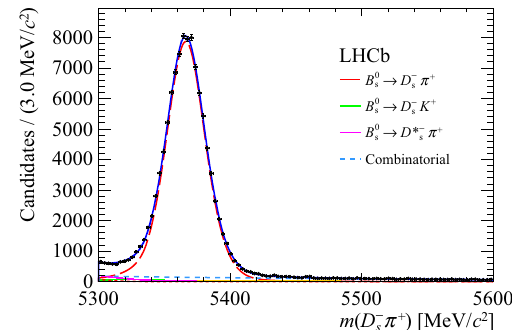
Fig. 9 Variation of the effective single-Gaussian decay-time resolu- tion, σ eff , as a function of the estimated per-event decay-time uncer- tainty, δ t , obtained from the prompt D − s π + sample. The red line shows the result of a linear fit to the data and the yellow band its uncertainty within one standard